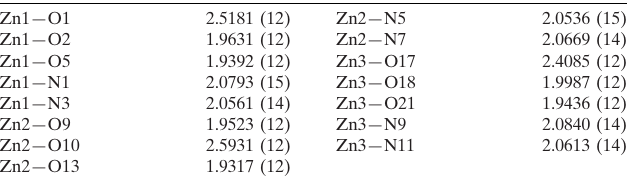
Selected bond lengths (A˚